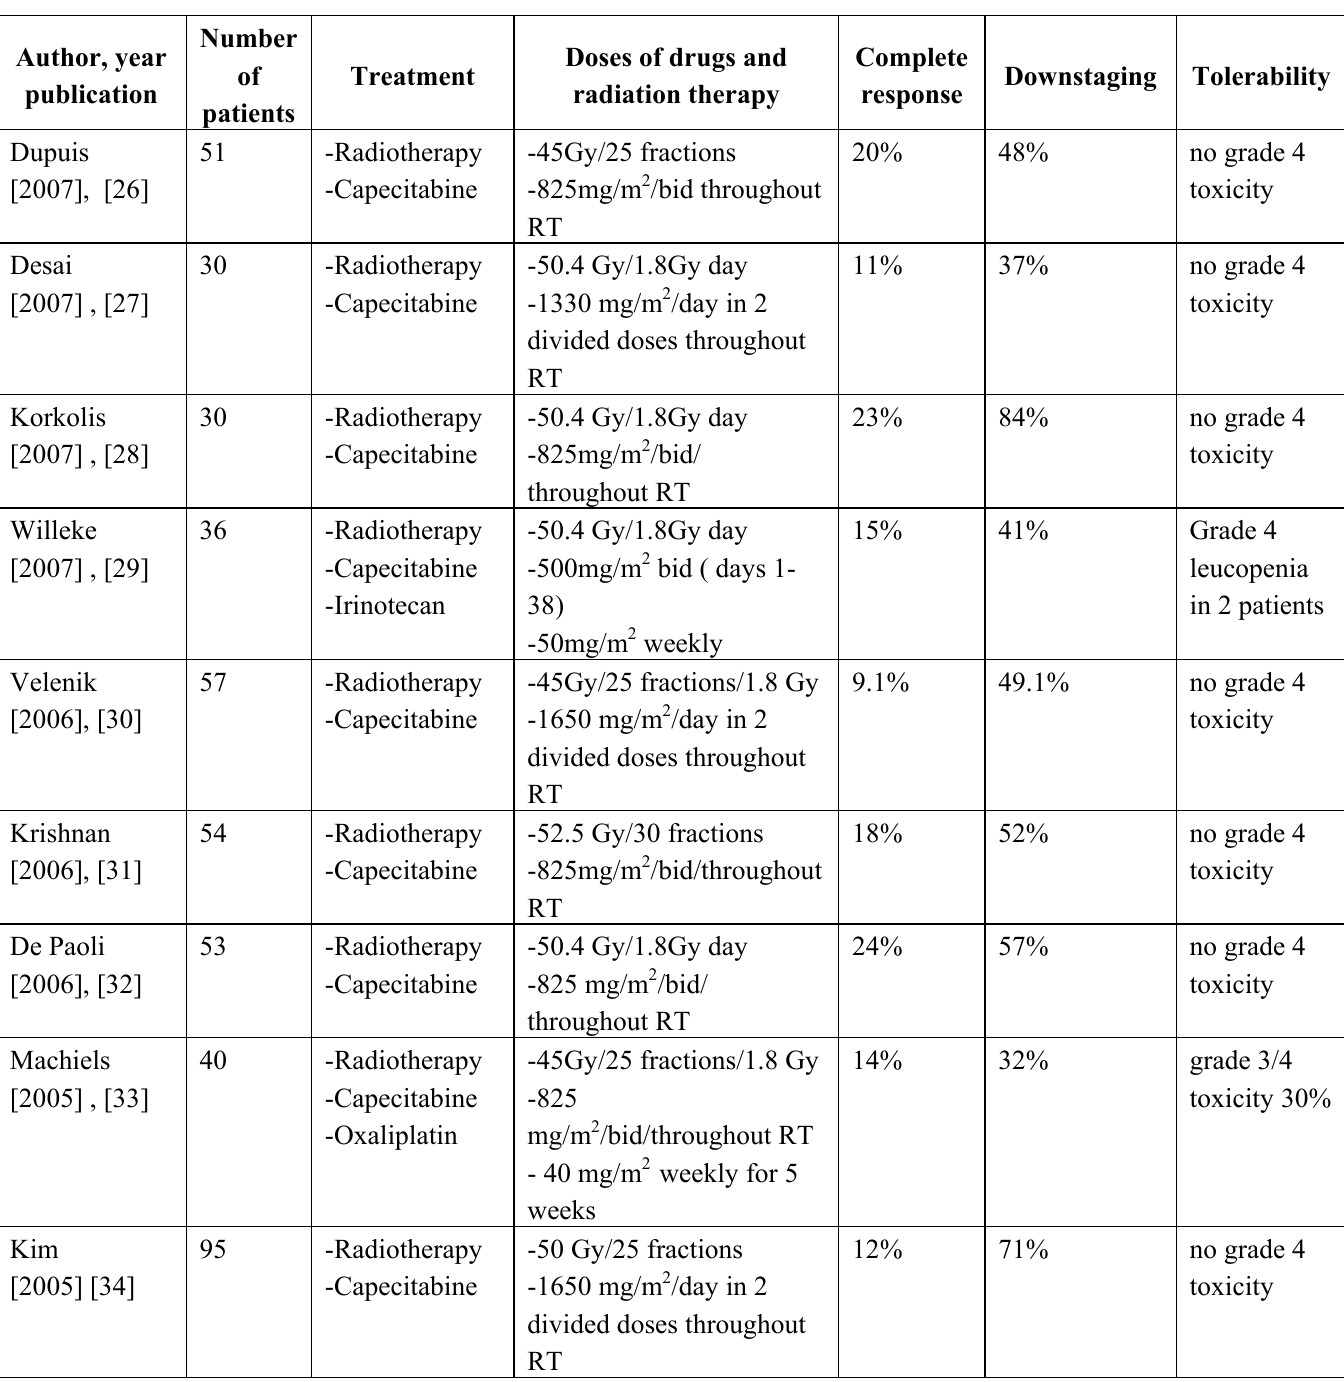
Table 3. Phase II trials of preoperative chemoradiotherapy in patients with locally advanced colorectal